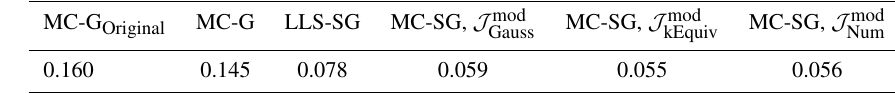
Figure 3. Centerline velocity deficit in the middle column of the farm; LES data scanned from Bastankhah et al. (2021). (a) Comparison between LES, the LLS method together with the super-Gaussian model (LLS-SG), and the momentum-conserving method together with the super-Gaussian formulations (MC-SG). (b) Comparison between LES and the momentum-conserving method and the Gaussian model, using the original (MC-G Original ) and modified (MC-G) formulations, and a super-Gaussian formulation (MC-SG). Table 2. Root-mean-square error of the analytical models against the LES results from Bastankhah et al.